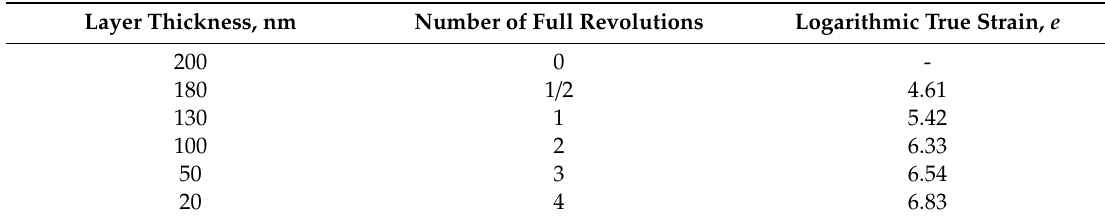
Table 1. Geometric parameters of Cu-Nb nanolaminates befor and after HPT, calculated logarithmic true